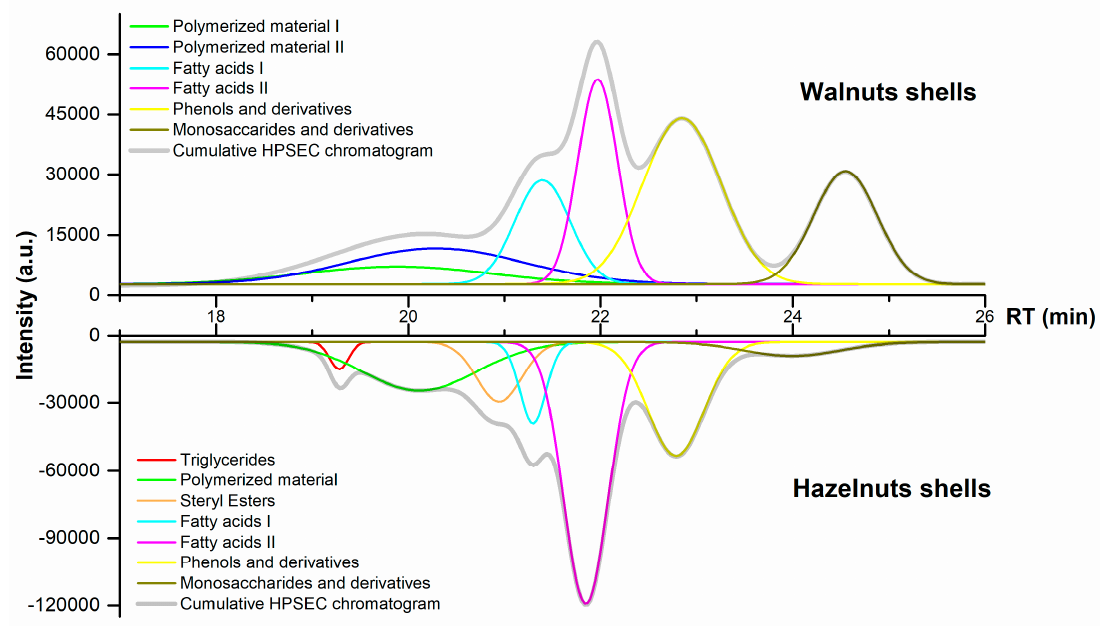
Figure 3. High-performance size-exclusion chromatography (HPSEC) chromatograms and deconvoluted signals from the polar extracts.